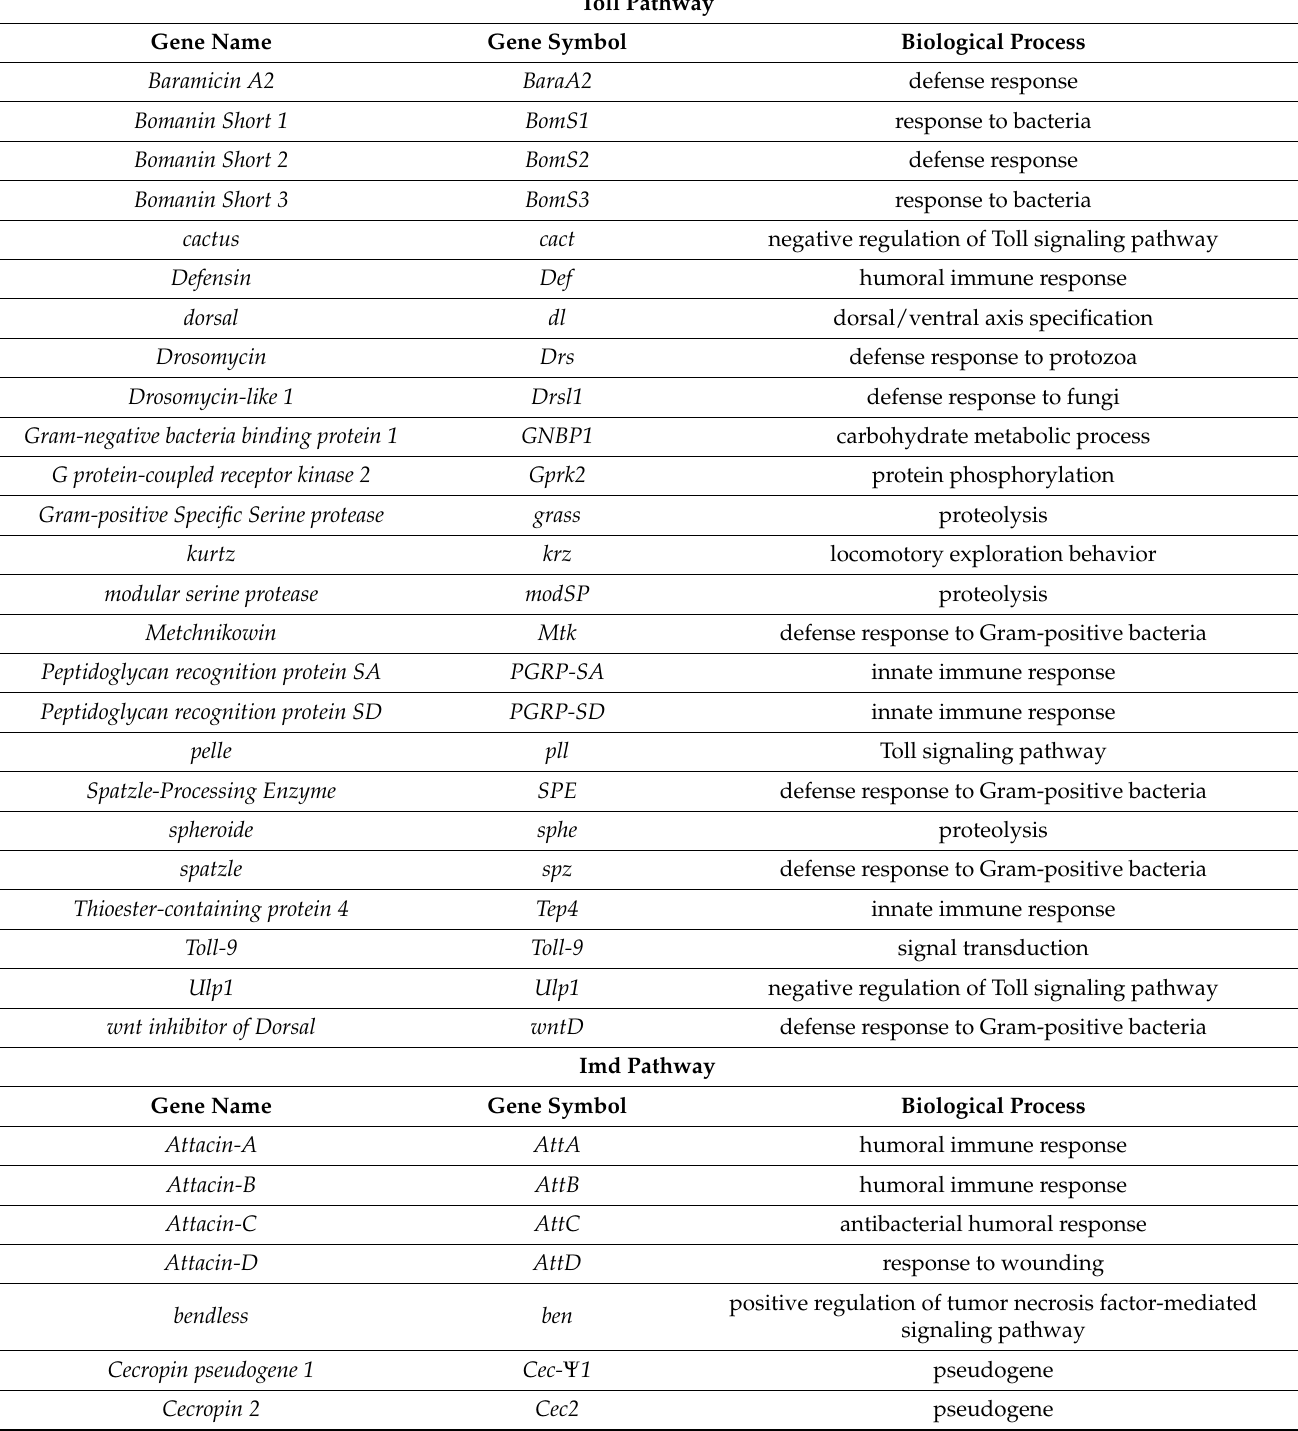
Table 1. The genes associated with Toll, Imd, and Imd-JNK pathways with significant modulation of expression in at least one experimental